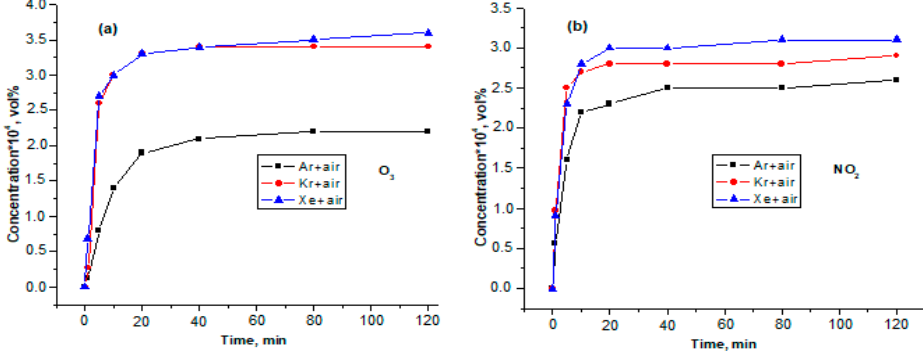
Figure 7. Dependence of O 3 ( a ) and NO 2 ( b ) concentrations on plasma treatment time of air mixtures with Ar, He, Kr and Xe.